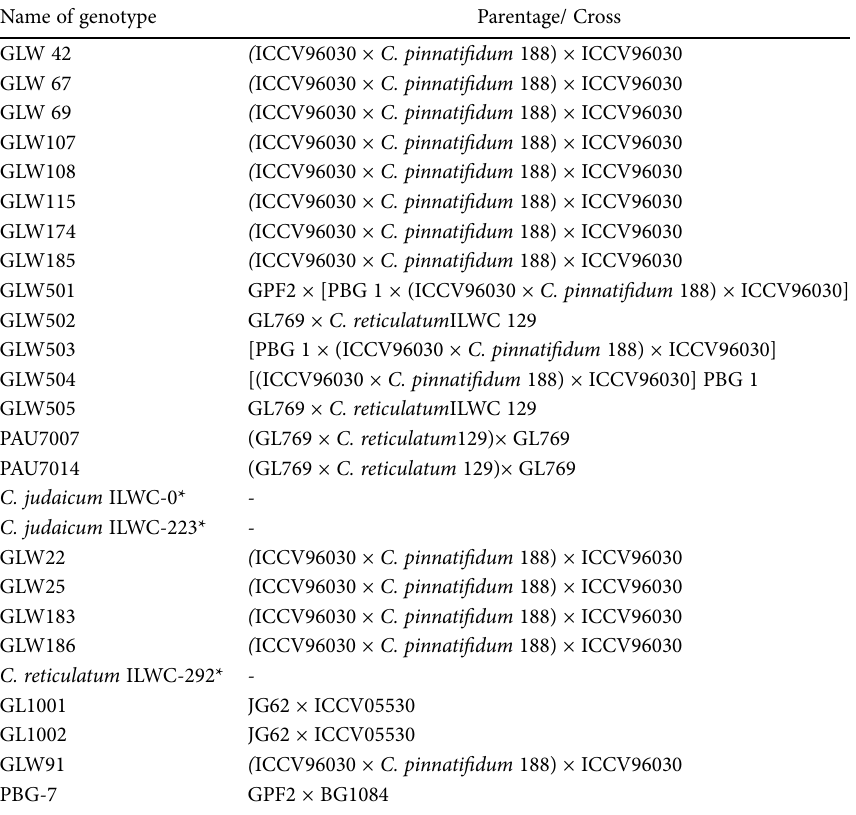
Table 1 Plant material used in this study with, their